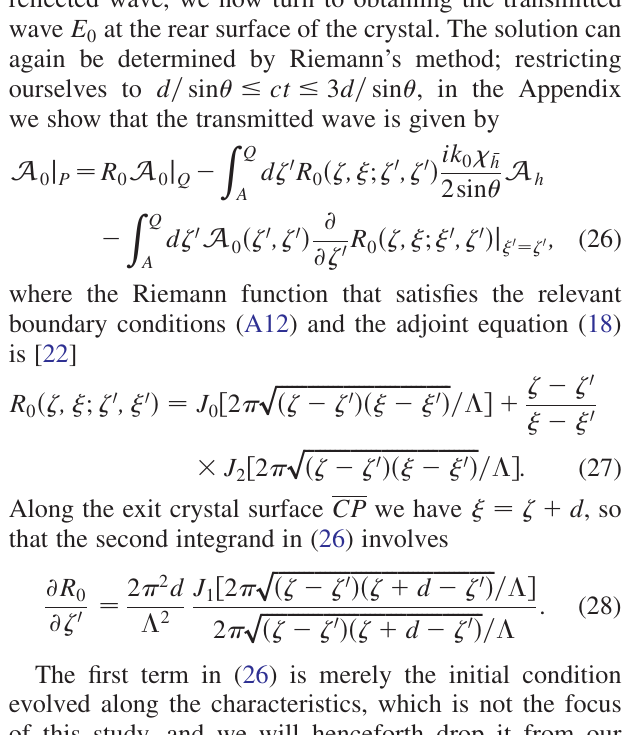
¼ c(cid:1) cot (cid:2) . o